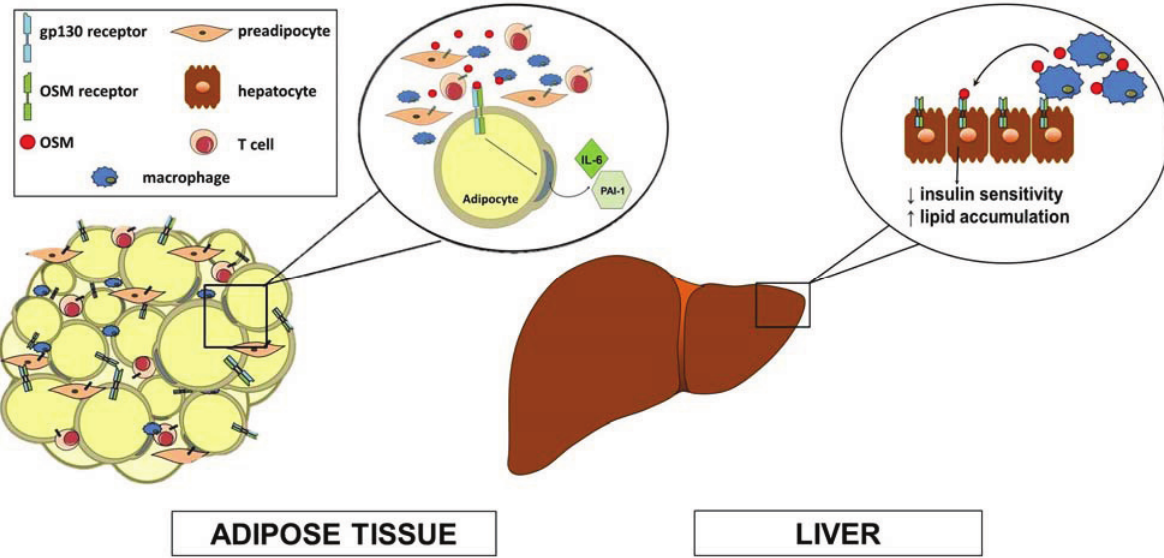
Figure 1. Oncostatin M (OSM) is produced in adipose tissue and liver immune cells and acts in a paracrine manner in these insulin-sensitive tissues. OSM is produced in T cells and macrophages that are found in adipose tissue and are elevated in conditions of obesity/insulin resistance. OSM receptors are present on preadipocytes and adipocytes, but not macrophages. It is well-known that OSM inhibits adipocyte differentiation. In addition, OSM acts on adipocytes to induce IL-6 and PAI-1 production. These abilities of OSM suggest that blocking OSM receptor activity in preadipocytes and adipocytes may be metabolically beneficial. In liver, OSM is produced in Kupffer cells (resident macrophages) and acts in a paracrine manner on hepatocytes to decrease insulin sensitivity and increase liver lipid